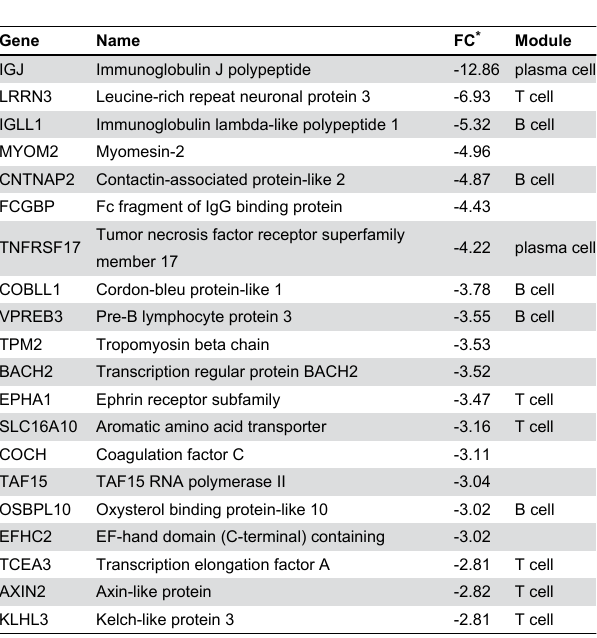
Table 6. Down regulated genes: Healthy controls vs. All